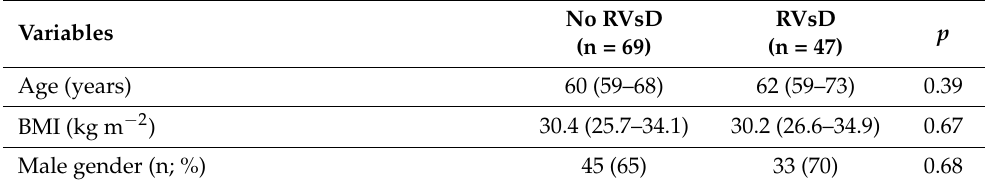
Table 1. Demographics, biological and computed tomography data before